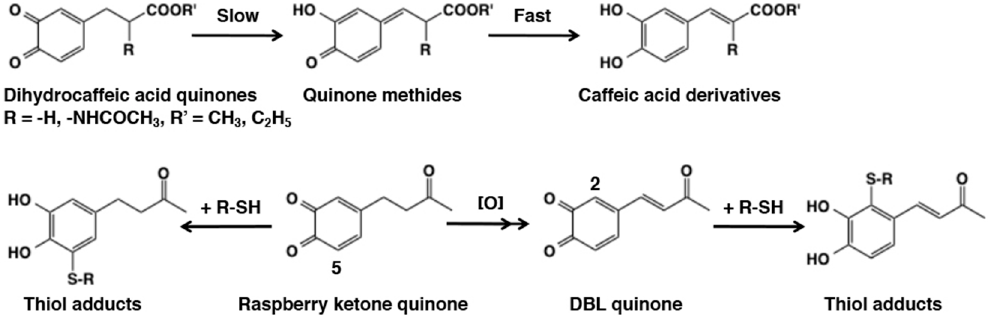
Figure 21. Side chain desaturation from quinone methides from dihydrocaffeic acid quinones [60] and raspberry ketone quinone [111]. Note that dihydrocaffeic acid (caffeic acid) with the N -acetyl group can be considered as dopa (dehydrodopa) derivative. The position of thiol addition differs between raspberry ketone quinone and DBL quinone.